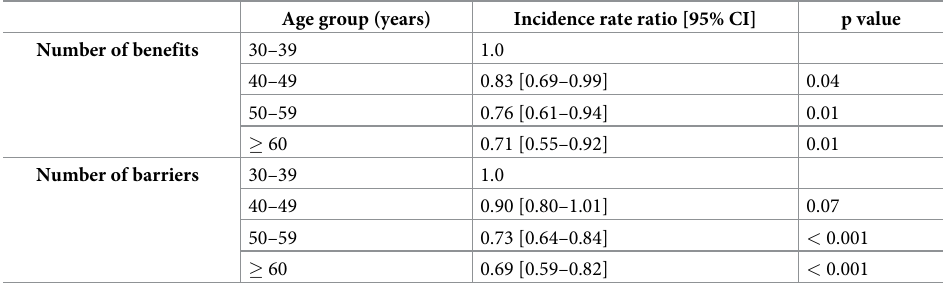
The incidence rate ratio represents a factor change in the expected number of benefits and barriers chosen by the participants. The age group 30–39 is used as the reference